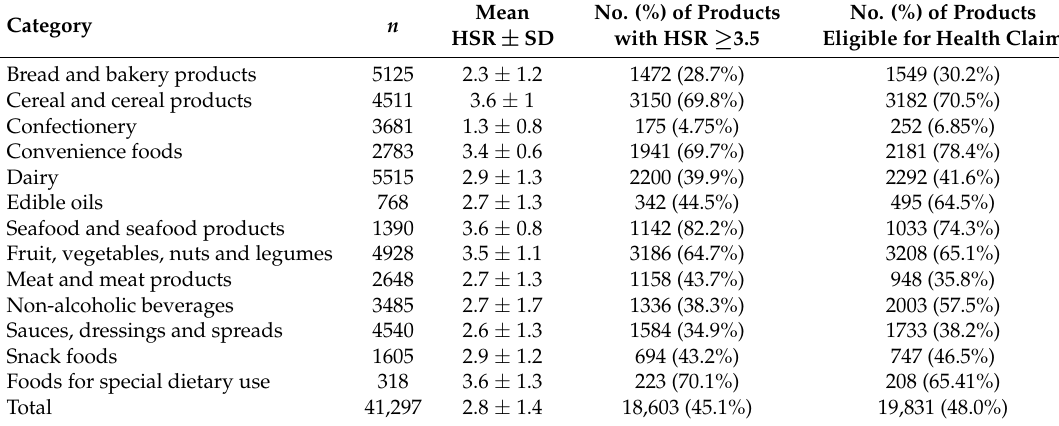
Table 1. Mean Health Star Ratings (HSR), proportion with HSR ≥ 3.5 and proportions eligible to carry health claim, overall and for major food